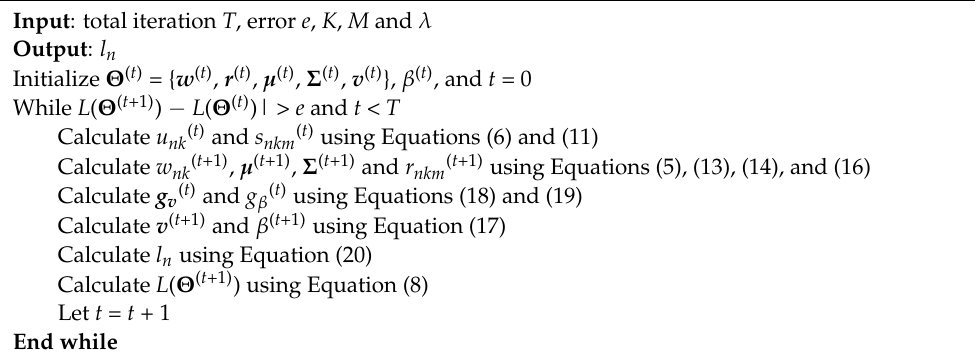
Algorithm 1. The spatial constraint HSMM-based segmentation algorithm